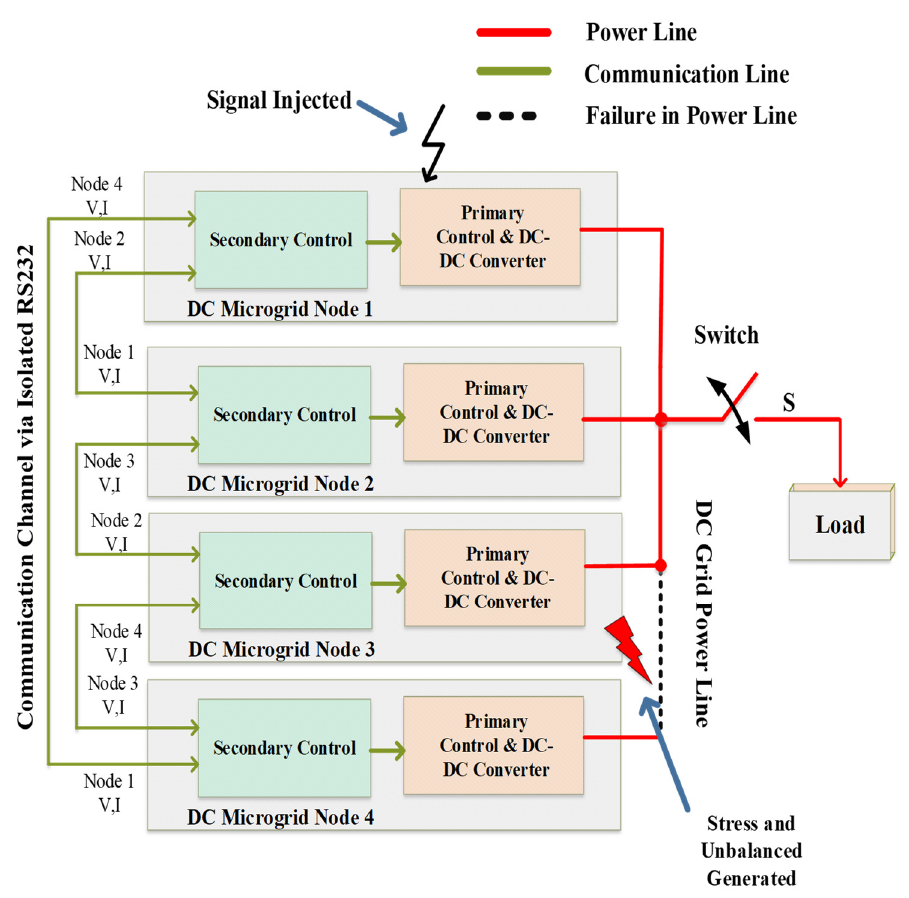
Figure 3. Experimental Setup Considered for the Physical Islanding Detection.